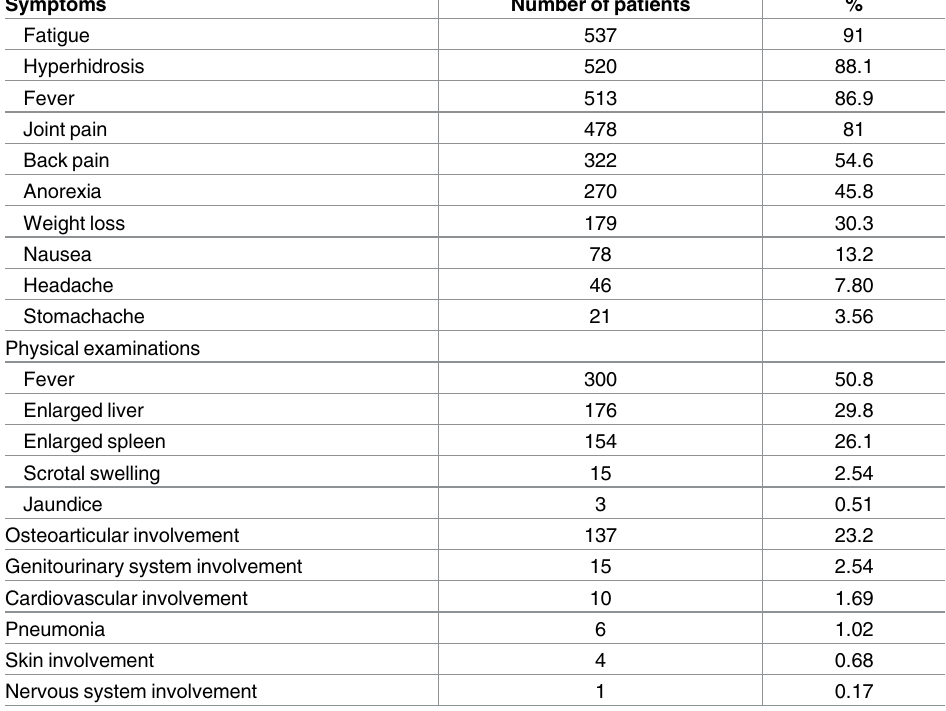
Table 2. Clinical characteristics of patients with